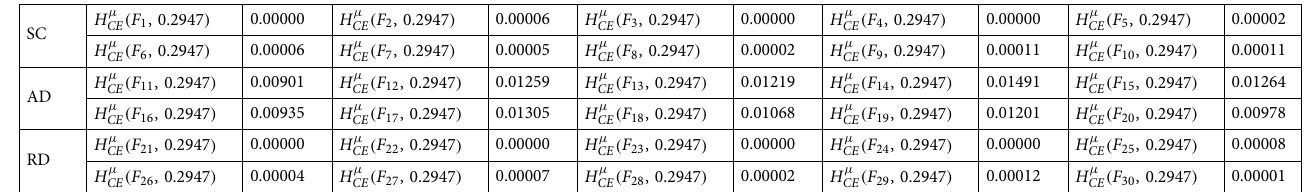
Table 7. Computation of FCE measure values between the fuzzy sets of various fault types in middle frequency range.